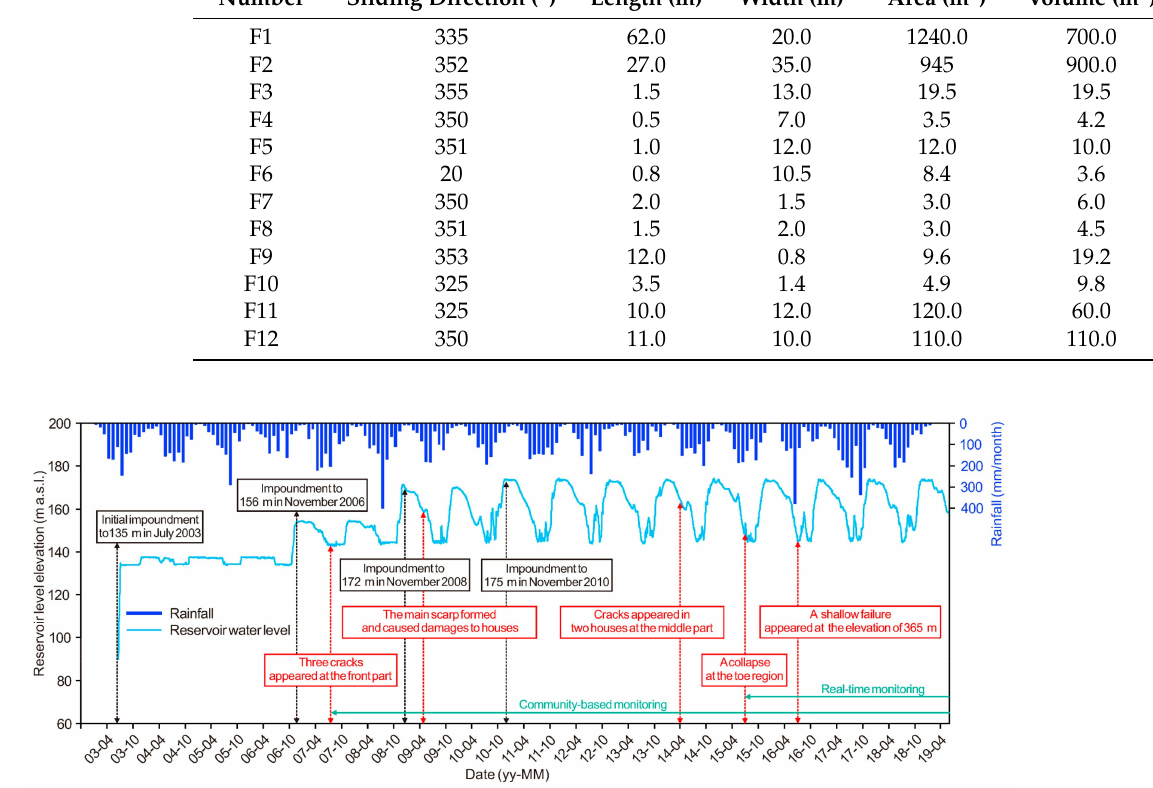
Figure 8. Time series of reservoir impoundments, rainfall, and significant landslide movements.